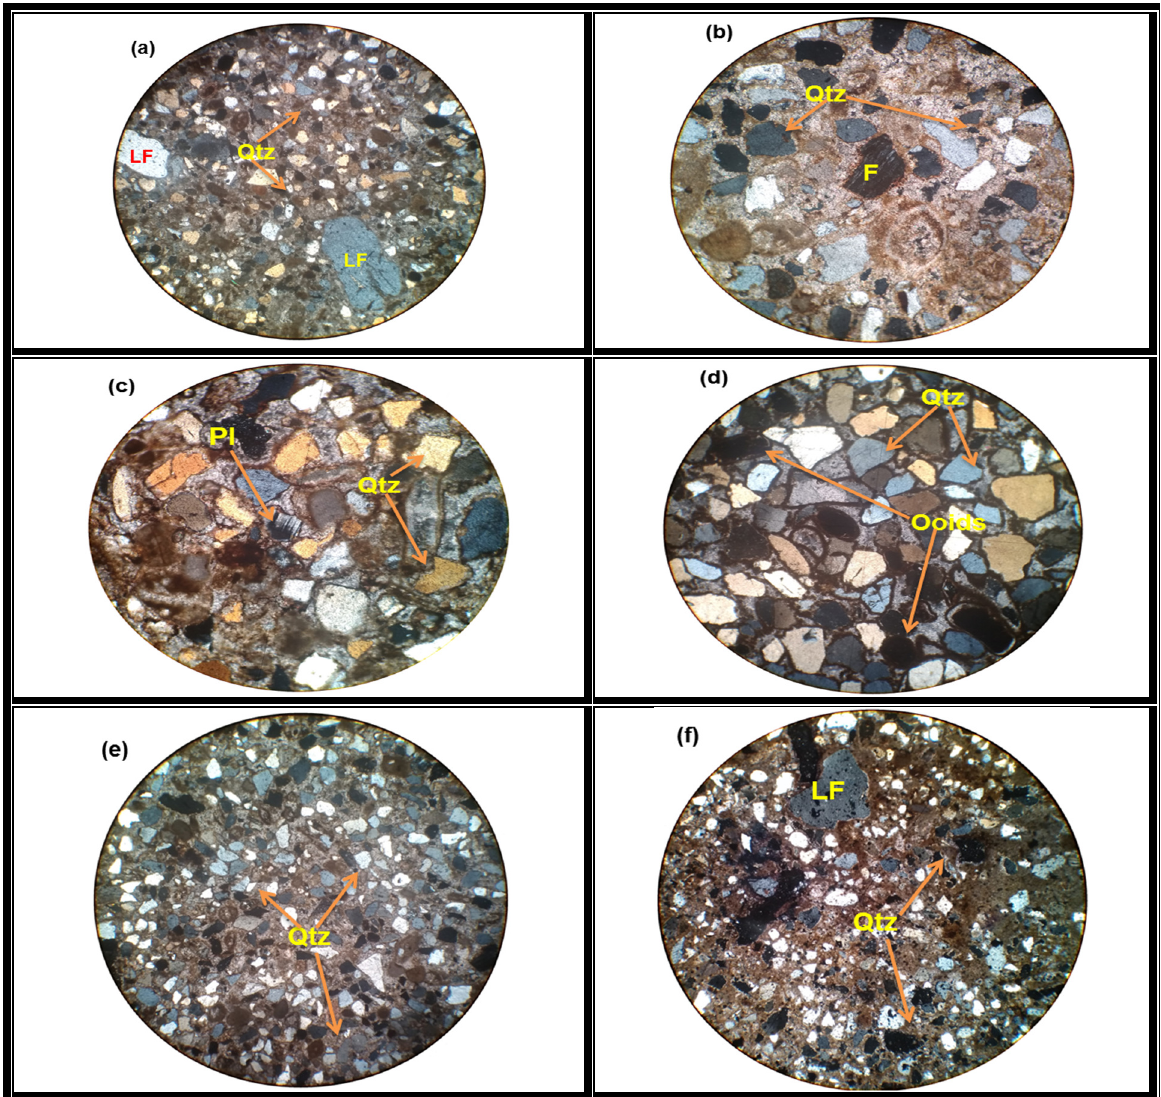
Fig. 2: Detailed Petrographic Description of the Nari sandstone samples. All photographs are taken in XPL